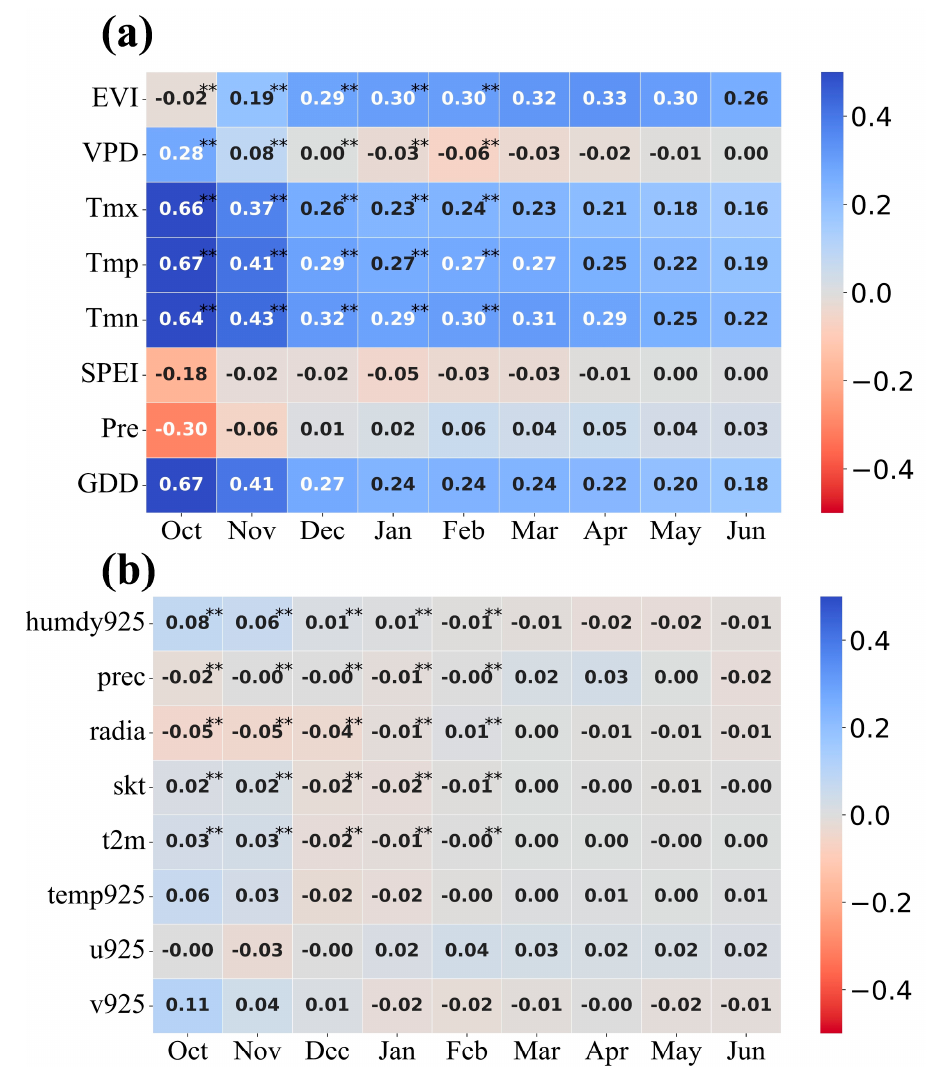
Figure 6. The correlation coefficient between observational climate variables ( a ) or FGOALS-f2 ensemble S2S atmospheric prediction ( b ) and yield. “**” indicates a correlation coefficient (r) with statistical significance levels of p -value < 0.01.